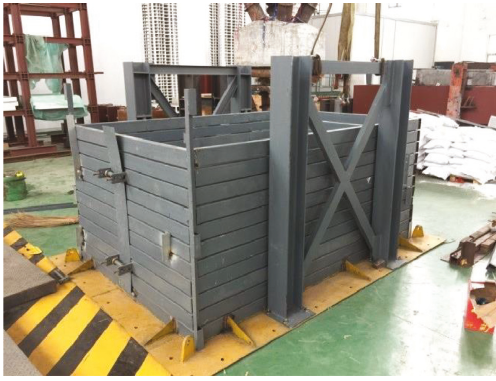
Figure 2: Laminar box. Table 1: Scale factors of the model